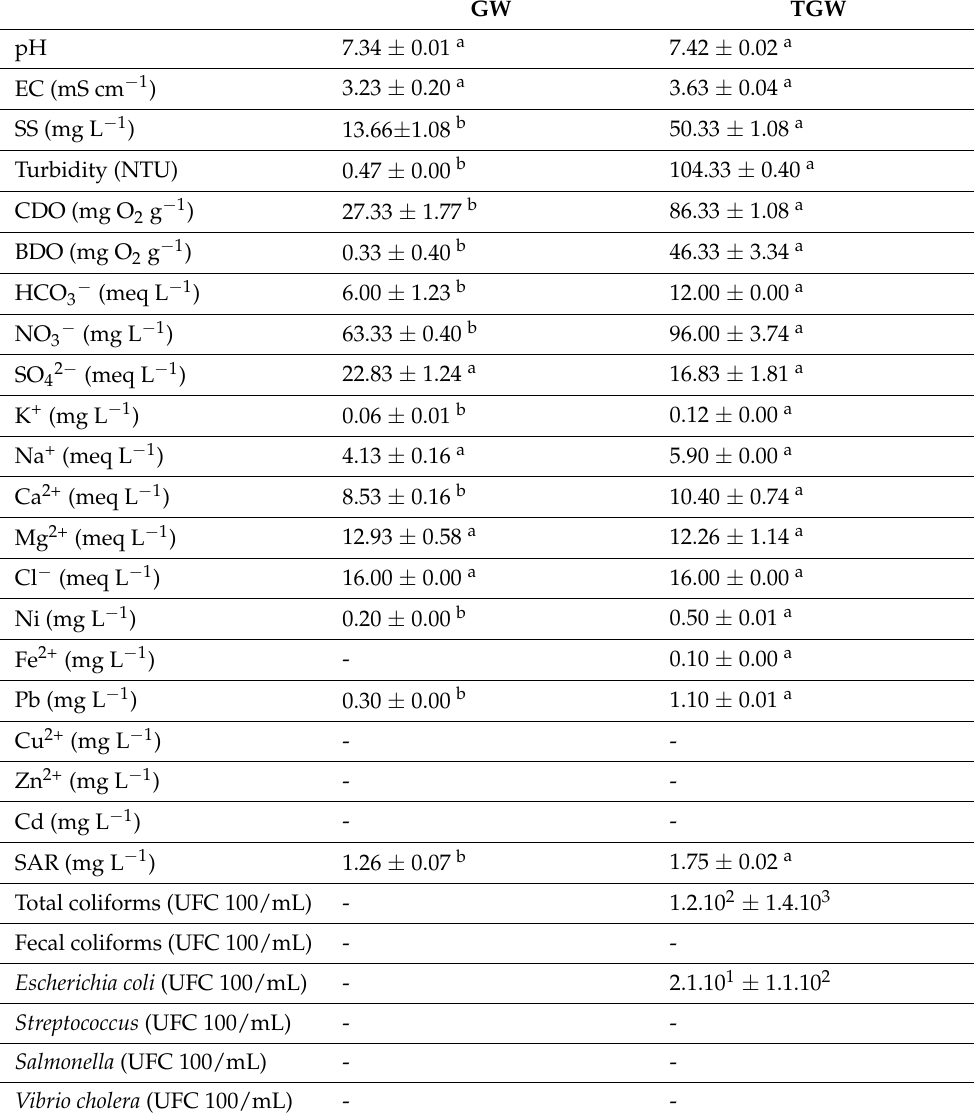
Table 1. Ionic and microbial characteristics of irrigation